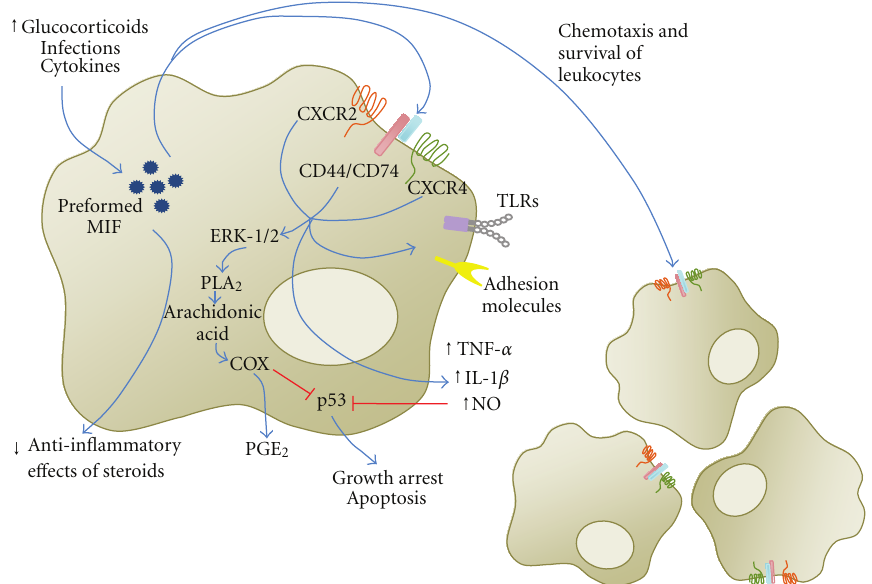
Figure 1: The e ff ects of MIF on macrophage activation. Release of preformed MIF induced by di ff erent types of stimuli, such as infections, cytokines, and variations on glucocorticoid levels, has paracrine and exocrine e ff ects: triggering of the CD44/CD74 receptor complex and the CXCR2 and CXCR4 chemokine receptors results in the production of tumor-necrosis-factor- α (TNF- α ), interleukin-1 (IL-1), and nitric oxide (NO,) as well as of arachidonic acid and eicosanoids through the induction of phospholipase A 2 and cyclooxygenase, and in increased expression of TLRs and adhesion molecules in macrophages. The exocrine e ff ects of MIF include induction of chemotaxis and promoting the survival of